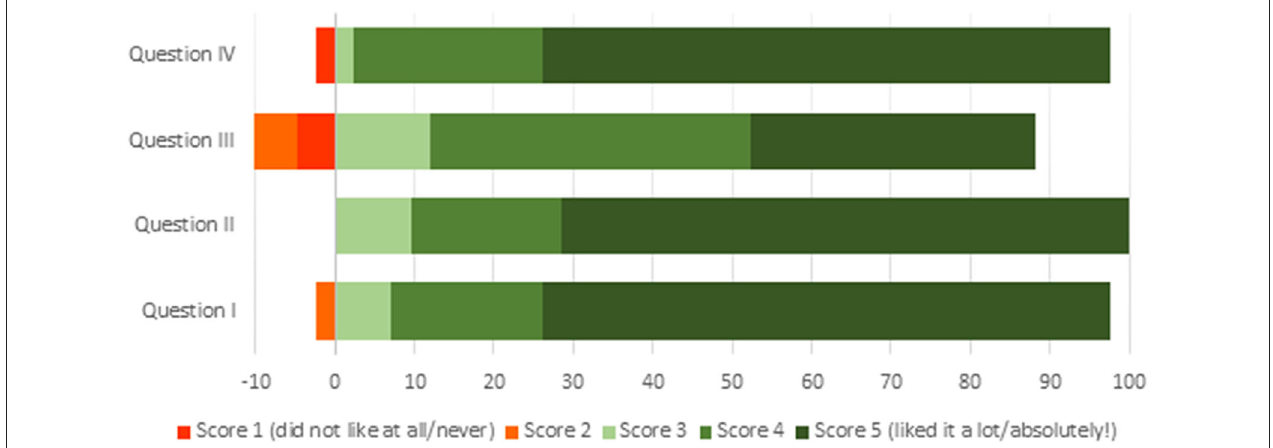
FIGURE 2 | Schematic presentation of the communication and documentation degree students to the anonymous online questionnaire. Questions are indicated with roman numbers. Question I: How much did you like the experience of conducting an interview on a television set? Question II: What is your opinion about participation of students from another faculty in the practice? Question III: Do you think this practice has helped you to strengthen your knowledge of the subject? Question IV: If you had the opportunity, would you repeat the experience?